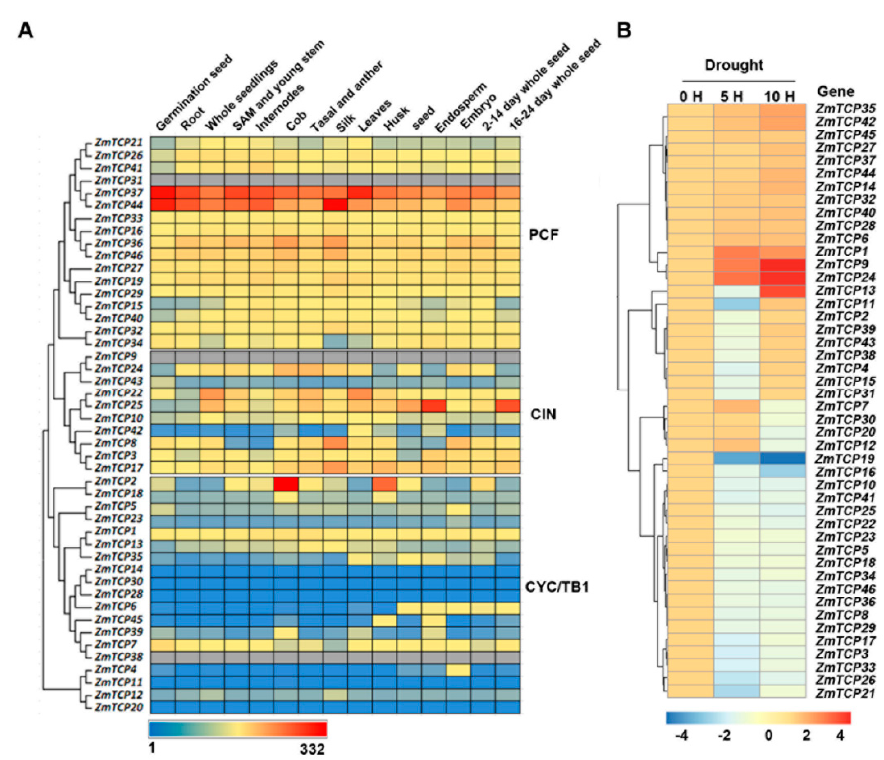
Figure 3. Expression patterns of ZmTCP genes in tissues and in response to drought conditions. ( A ) A heat map depicting gene expression levels of 46 ZmTCPs in fifteen di ff erent tissues from various developmental stages. Normalized gene expression values are shown in di ff erent colors that represent the levels of expression indicated by the scale bar. The gray color represents unavailable data. ( B ) Microarray-based expression analysis of ZmTCP genes. A heat map was generated based on the fold-change values in the treated samples, when compared with the unstressed control. The color scale for fold-change values is shown at the bottom. The drought-treated leaf samples were collected at two time points, 5 and 10 h, which reflected relative leaf water content (RLWC) of 70% and 60%, respectively.